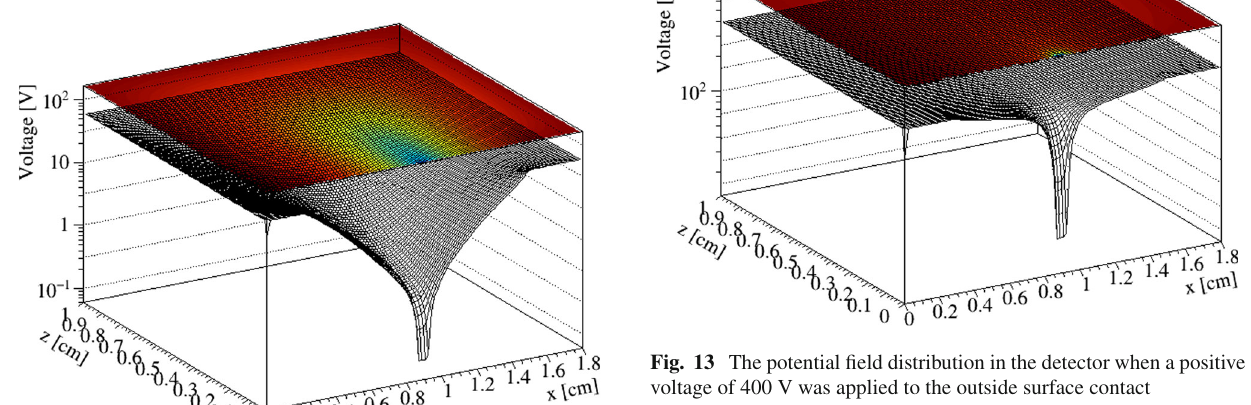
Fig. 10 The potential field distribution in the detector when a positive voltage of 55 V was applied to the outside surface contact. The white area indicates that the detector is not fully depleted